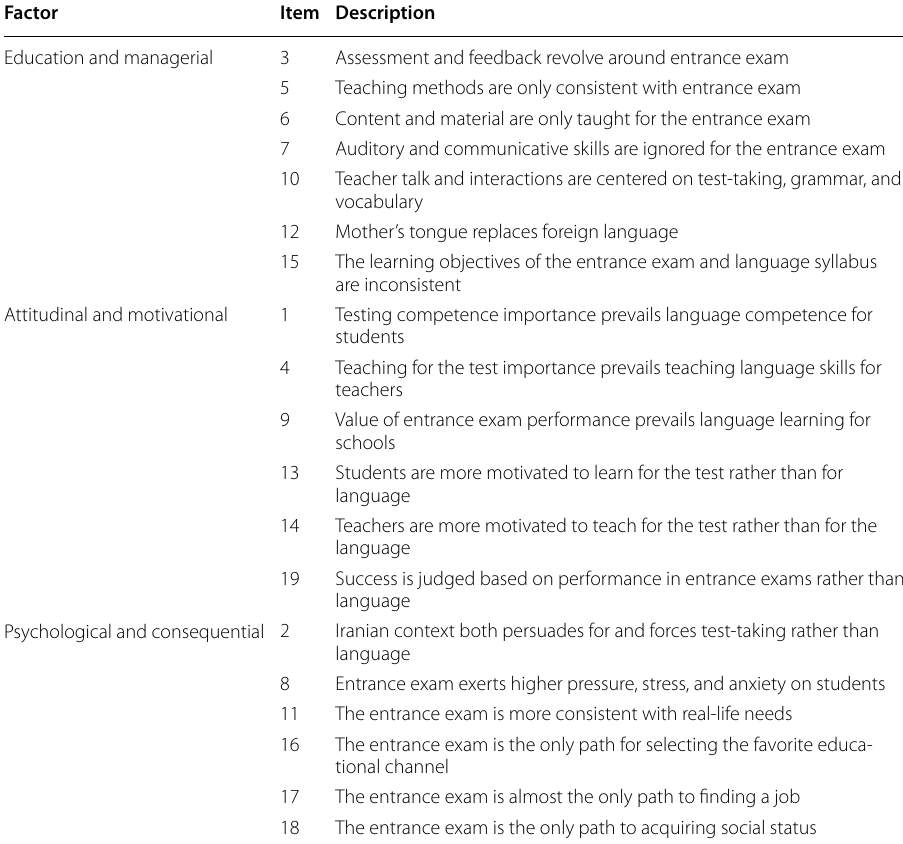
Table 5 Descriptions of items extracted from exploratory factor analysis Factor Item Description